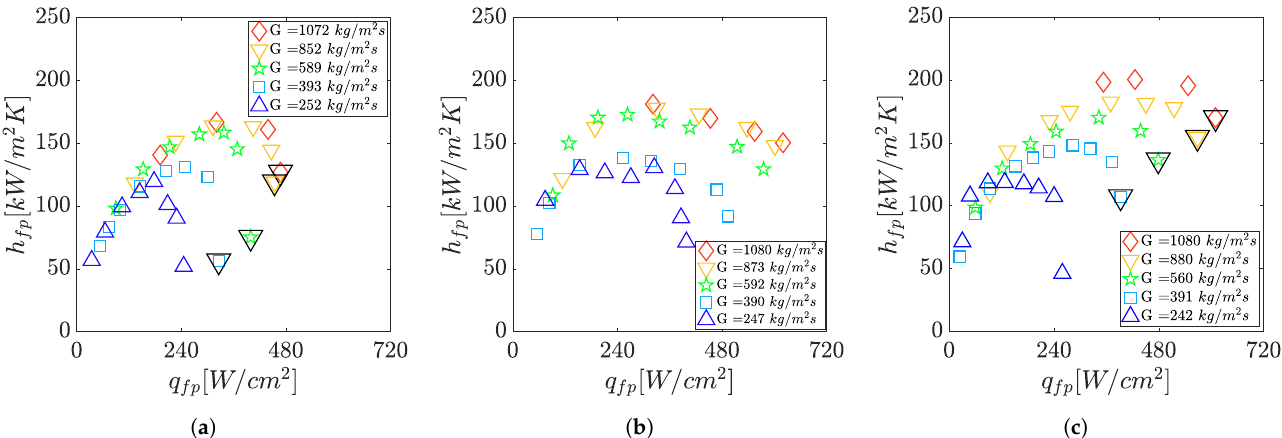
Figure 6. Footprint heat transfer coefficient h fp versus q fp in Geometry A ( a ), B ( b ), and C ( c ) at a nominal saturation ◦ temperature of 30 C at the outlet of the channels.